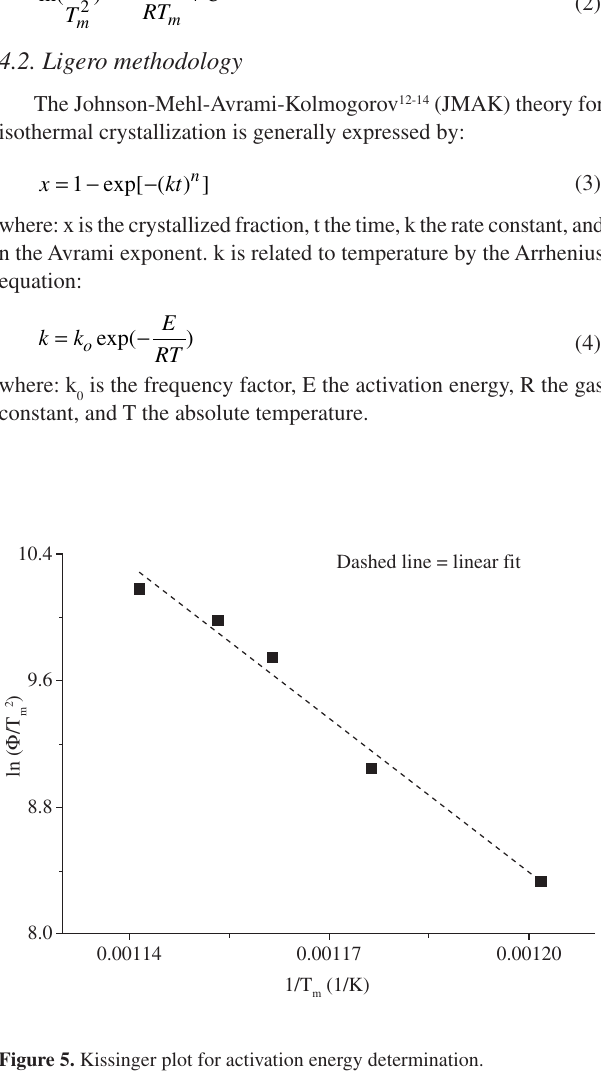
Figure 5. Kissinger plot for activation energy determination. Figure 6. Arrhenius plot for DSC obtained at 5